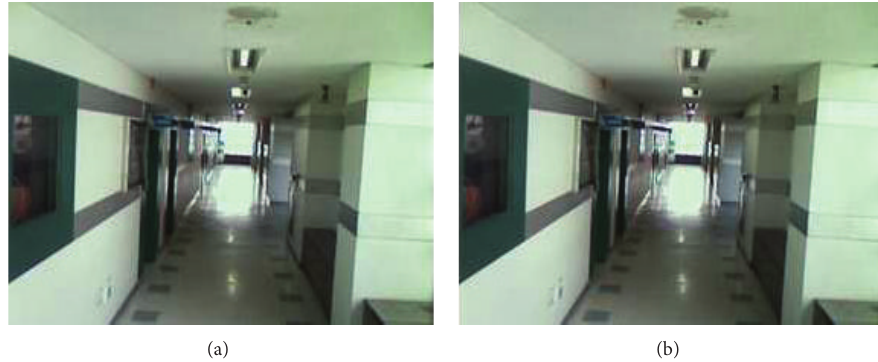
Figure 10: Before (a) and after (b) the insertion of steganography.